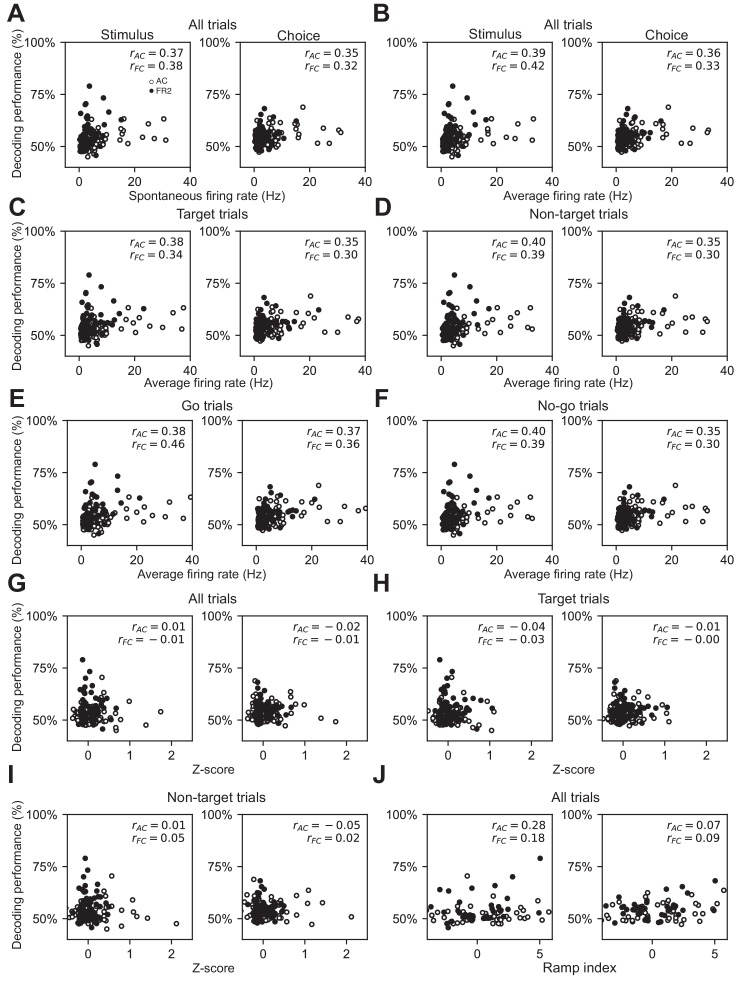
Lack of correlations between classical firing rate metrics and stimulus or choice decoding performance.(A) Stimulus and choice decoding performance versus the spontaneous firing rate for both target and non-target trials, (rAC = 0.37, 0.35; slopeAC = 2.3 × 10−3, 2.2×10−3; pAC = 1.7 × 10−4, 4.1 × 10−4; rFR2 = 0.38, 0.30; slopeFR2 = 8.9 × 10−3, 4.6 × 10−3; pFR2 = 8.2 × 10−4, 6.6 × 10−3). (B) Stimulus and choice decoding performance versus average firing rate for both target and non-target trials, (rAC = 0.39, 0.36; slopeAC = 2.3 × 10−3, 2.1 × 10−3; pAC = 7.8 × 10−5, 3.0 × 10−4; rFR2 = 0.42, 0.33; slopeFR2 = 8.7 × 10−3, 4.5 ×10−3; pFR2 = 2.3 × 10−4, 3.8 × 10−3). (C) Stimulus and choice decoding performance versus average firing rate for target trials only, (rAC = 0.38, 0.35; slopeAC = 1.9 × 10−3, 1.8 × 10−3; pAC = 1.0 × 10−4, 4.2 × 10−4; rFR2 = 0.34, 0.30; slopeFR2 = 5.4 × 10−3, 3.0 × 10−3; pFR2 = 3.2 × 10−3, 0.011). (D) Stimulus and choice decoding performance versus average firing rate for non-target trials only, (rAC = 0.40, 0.35; slopeAC = 2.2 × 10−3, 1.9 × 10−3; pAC = 4.0 × 10−5, 6.6 × 10−4; rFR2 = 0.39, 0.30; slopeFR2 = 5.3 × 10−3, 2.5 × 10−3; pFR2 = 2.9 × 10−4, 0.010). (E) Stimulus and choice decoding performance versus average firing rate for go trials only, (rAC = 0.38, 0.37; slopeAC = 1.9 × 10−3, 1.9 × 10−3; pAC = 1.4 × 10−4, 2.3 × 10−4; rFR2 = 0.46, 0.36; slopeFR2 = 7.6 × 10−3, 3.8 × 10−3; pFR2 = 3.6 × 10−5, 2.0 × 10−3). (F) Stimulus and choice decoding performance versus average firing rate for no-go trials only, (rAC = 0.40, 0.35; slopeAC = 2.1 × 10−3, 1.9 ×10−3; pAC = 6.1 × 10−5, 4.7 × 10−4; rFR2 = 0.39, 0.30; slopeFR2 = 7.5 × 10−3, 3.7 × 10−3; pFR2 = 5.9 × 10−4, 9.2 ×10−3). (G) Stimulus and choice decoding performance versus z-score for all trials, (rAC = 0.01,–0.02; slopeAC = 1.3 × 10−3, −2.4 × 10−3; pAC = 0.91, 0.83; rFR2 = 0.01,–0.01; slopeFR2 = −2.3 × 10−3, −1.8 ×10−3; pFR2 = 0.95, 0.94). (H) Stimulus and choice decoding performance versus z-score for target trials only, (rAC = −0.04,–0.01; slopeAC = −5.1 × 10−3, −1.6 ×10−3; pAC = 0.72, 0.91; rFR2 = −0.03,–0.002; slopeFR2 = −6.7 × 10−3, −1.9 × 10−4; pFR2 = 0.81, 0.99). (I) Stimulus and choice decoding performance versus z-score for non-target trials only, (rAC = 0.01,–0.05; slopeAC = 1.0 × 10−3, −4.3 × 10−3; pAC = 0.90, 0.61; rFR2 = 0.05, 0.02; slopeFR2 = 0.017, 4.3 × 10−3; pFR2 = 0.68, 0.87). (J) Stimulus and choice decoding performance versus ramp index, (rAC = 0.28, 0.07; slopeAC = 5.1 × 10−4, 1.3 × 10−4; pAC = 5.9 × 10−3, 0.49; rFR2 = 0.18, 0.09; slopeFR2 = 4.5 × 10−4, 1.4 × 10−4; pFR2 = 0.13, 0.47).